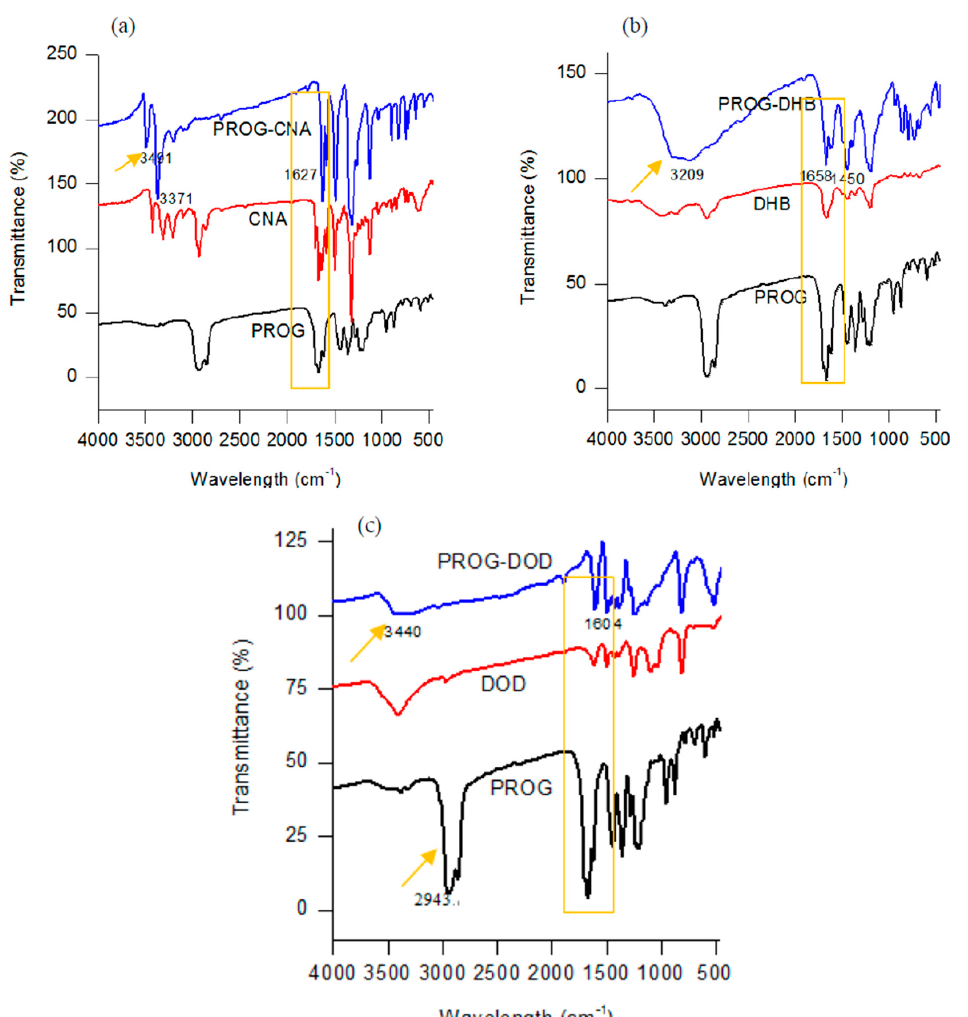
Figure 5. Combined FT-IR spectra of ( a ) CNA, PROG-CNA, and PROG; ( b ) DHB, PROG-DHB, and PROG; and ( c ) DOD, PROG-DOD, and PROG.